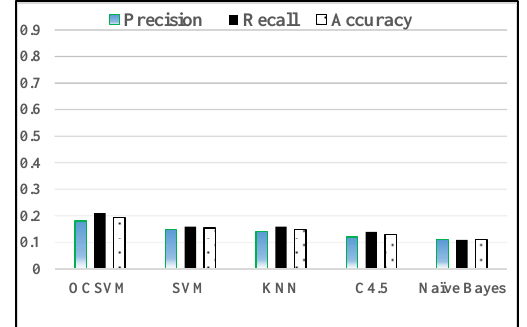
Figure 10. Results of different classification method evaluations with feature vector creating by 14 features mentioned in table